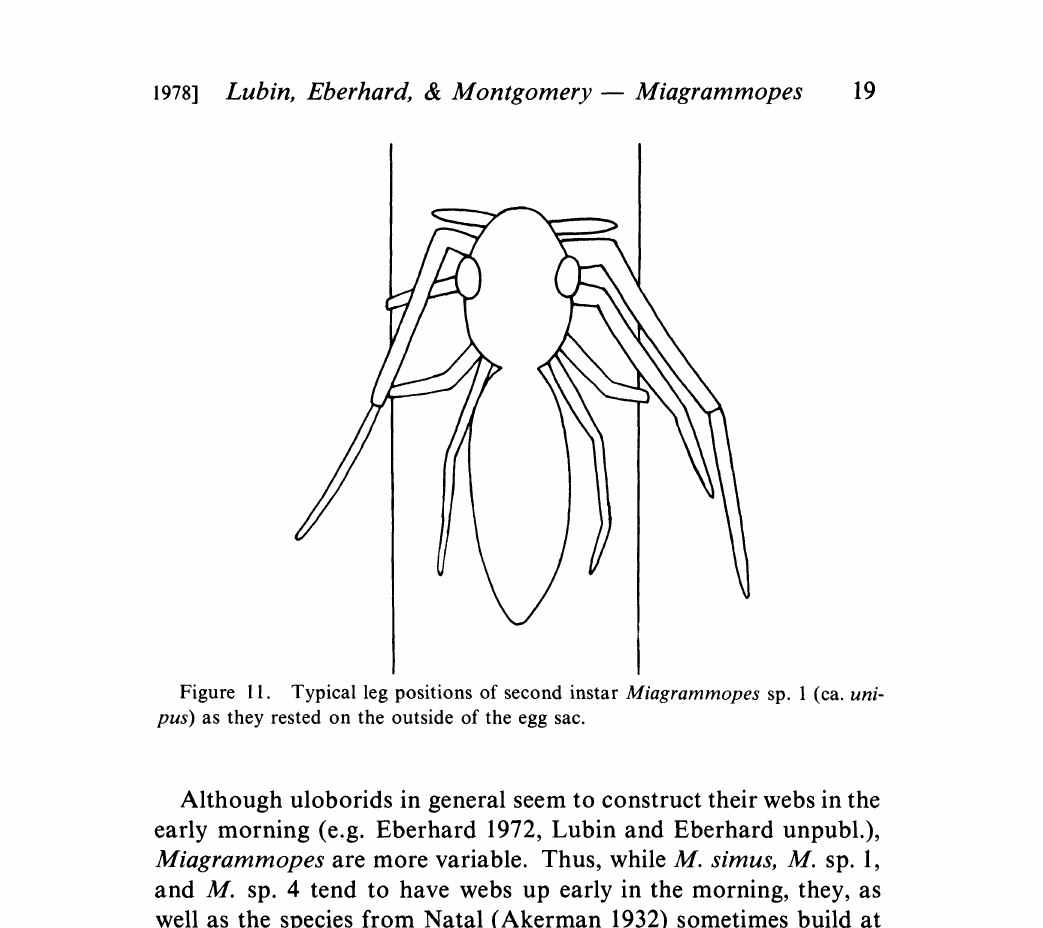
Figure 11. Typical leg positions of second instar Miagrammopes sp. (ca. uni- pus) as they rested on the outside of the egg